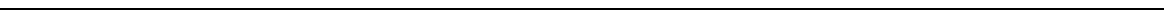
Fig. 2 CREB activation in HIPP cells during background context conditioning. a Lentiviral vector constructs for the conditional expression of control (HA), native CREB and dominant negative CREB S133A . b Schematic of the viral transduction and behavioral testing paradigm. c CREB S133A ( n = 8) increases fear memory to the background context, while the fear response to the CS remains unaltered (controls n = 10). d The overexpression of native CREB in SST-Cre ERT2 mice increases, whereas dominant negative CREB S133A reduces NPY mRNA levels in the hilus ( n = 6 each). GAD67 mRNA is also increased by CREB overexpression. SST mRNA by contrast is increased in the CREB S133A group with a non-signi fi cant trend for native CREB, indicative of a phosphorylation-independent constitutive expression regulation. Note the inverted scaling of the ordinate, the lower values indicate higher expression. e A representative microscopic image shows the lentiviral expression in the hilus. Green , HA; blue , DAPI. Scale bar, 10 μ m. For an overview, please see Supplementary Fig. 4c. f A schematic of the proposed circuit and the site of CREB manipulation. g The proportion of pCREB S133 /GFP double positive cells in the hilus of NPY-GFP transgenic mice is selectively increased 1 h after background context conditioning ( n = 6 each). h Representative microscopic images show phosphorylated CREB expression in the hilus and granule cell layer of the DG. Arrows , pCREB S133 /GFP double-labeled cells. Scale bar, 25 μ m. Data are means + s.e.m. Statistical analysis was done with Student ’ s unpaired t -test in c , and by Fisher ’ s LSD following one-way ANOVA in d and g